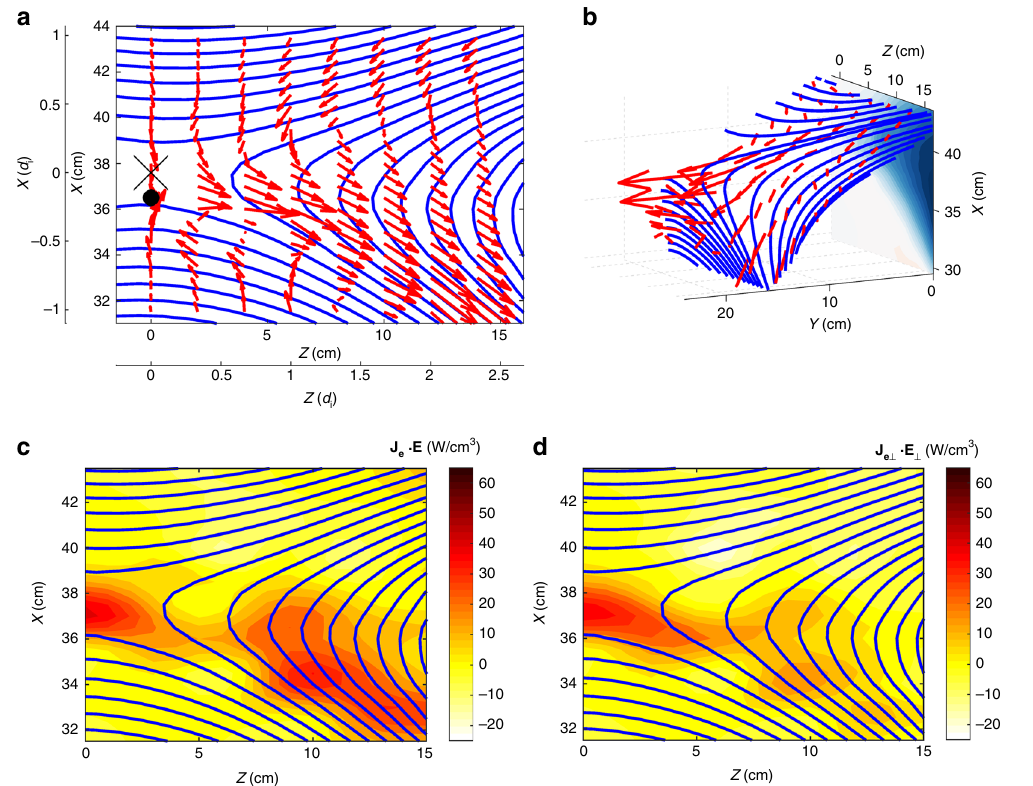
Fig. 2 Electron dynamics observed in MRX. a In the reconnection plane, electron fl ows together with reconnecting fi eld lines. The X marker at ( R , Z ) = (37.6, 0) is the X-line and the black circle denotes the stagnation point of in-plane electron fl ow. b 3D views of electron fl ow vectors with respect to the reconnecting fi eld lines. Because of the dipole structure of out-of-plane magnetic fi eld, the reconnection plane is tilted in the Y -axis. in the high density (upper) side. Note that strong electron current in Y -direction at the stagnation point. c Energy deposition to electrons through j e · E is concentrated in the electron diffusion region around the stagnation point as well as in the lower density side of exhaust. d Perpendicular component, j e ⊥ ∙ E ⊥ is much larger than j e|| E || and concentrated in the electron stagnation point, while the contribution from j e|| E || is notable at the lower density side of the exhaust as seen in c and